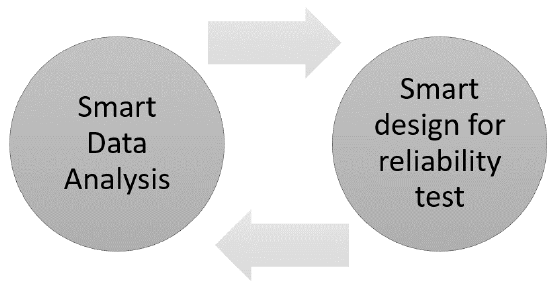
Figure 14. Learning how to improve the design process from data analysis.